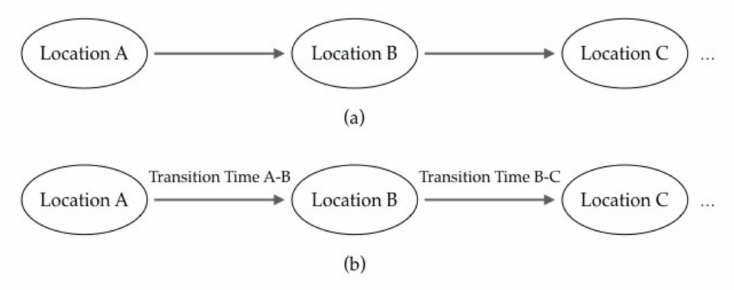
Figure 3. Frequent patterns based on ( a ) spatial sequences and ( b ) spatiotemporal sequences.